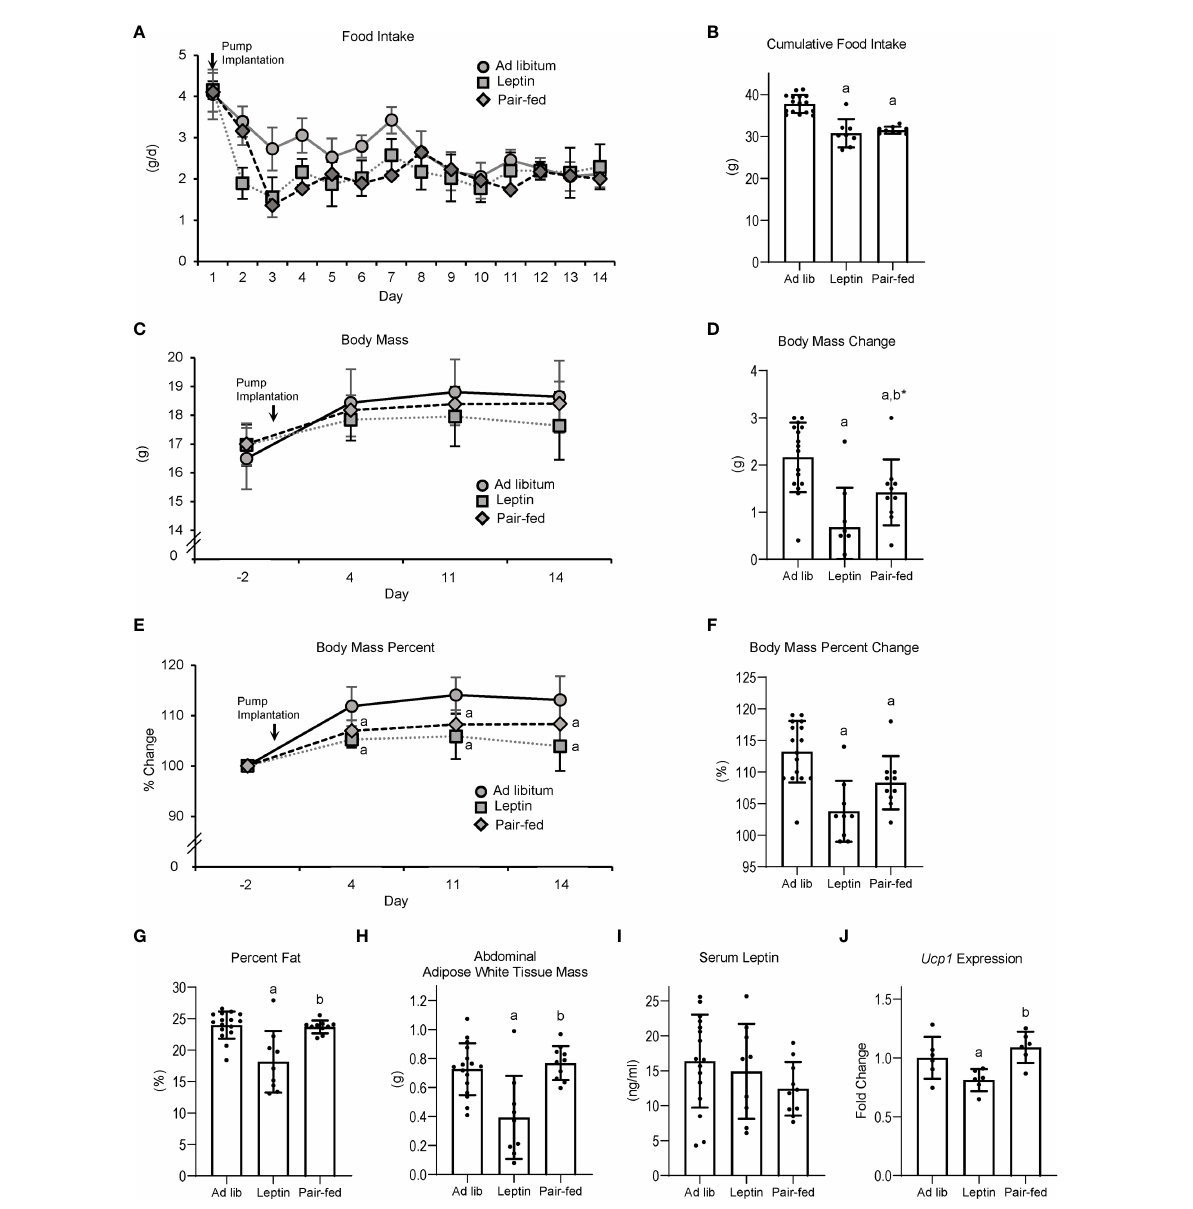
FIGURE 2 Effects of leptin supplementation and pair feeding on food intake over duration of treatment (A) , cumulative food intake (B) , body mass (C) , body mass change over duration of treatment (D) , percent change in body mass relative to baseline mass (E) , cumulative percent change in body mass relative to baseline mass (F) , percent body fat (G) , abdominal white adipose tissue mass (H) , serum leptin (I) , and brown adipose tissue Ucp1 gene expression (J) in C57BL/6J female mice. Data are mean ± SD with individual data points shown as dots. N = 9-16/group for panels (A – G) and n = 8/group for panel (H) Analysis of variance followed by appropriate posthoc tests was used to assess differences among groups. a Different from ad lib , FDR-adjusted P < 0.05. b Different from leptin, FDR-adjusted P<0.05; b